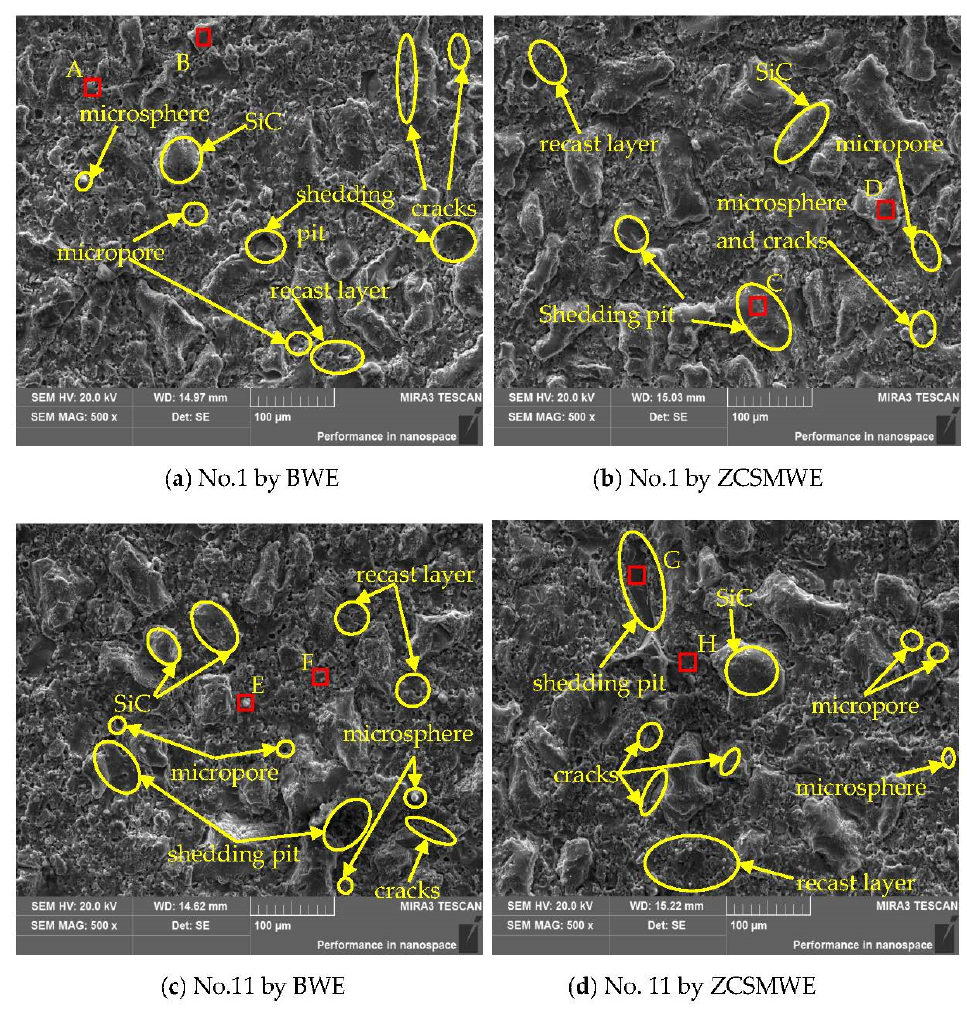
Figure 6. SEM images of the workpiece surface topography.